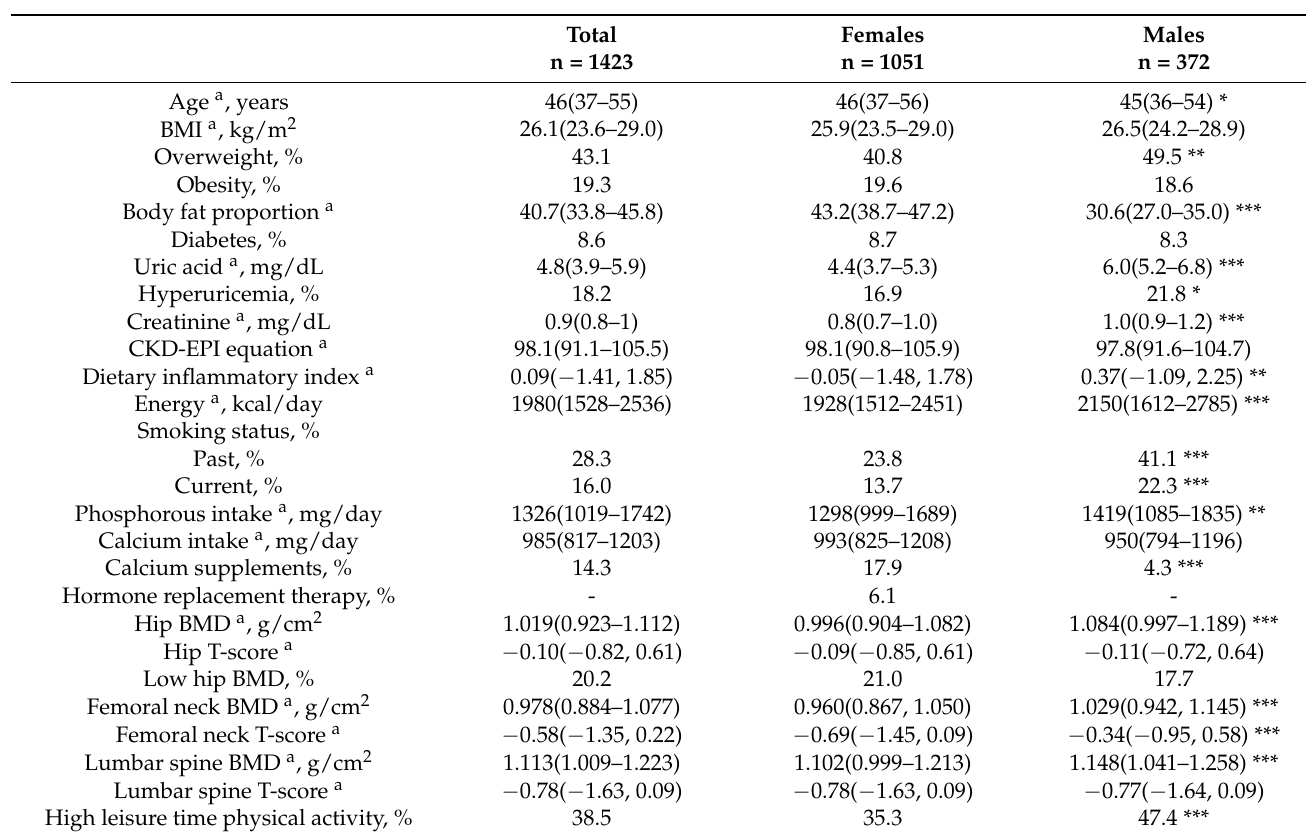
Table 1. Baseline characteristics of the Health Workers Cohort Study (HWCS) by